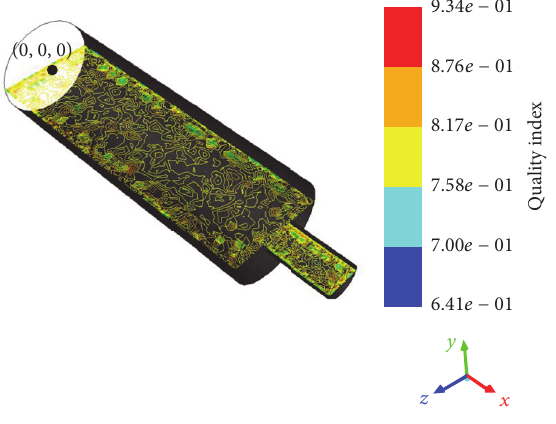
Figure 6: Contours of orthogonal quality.